Question: Looking at the figure, what chart type is it?
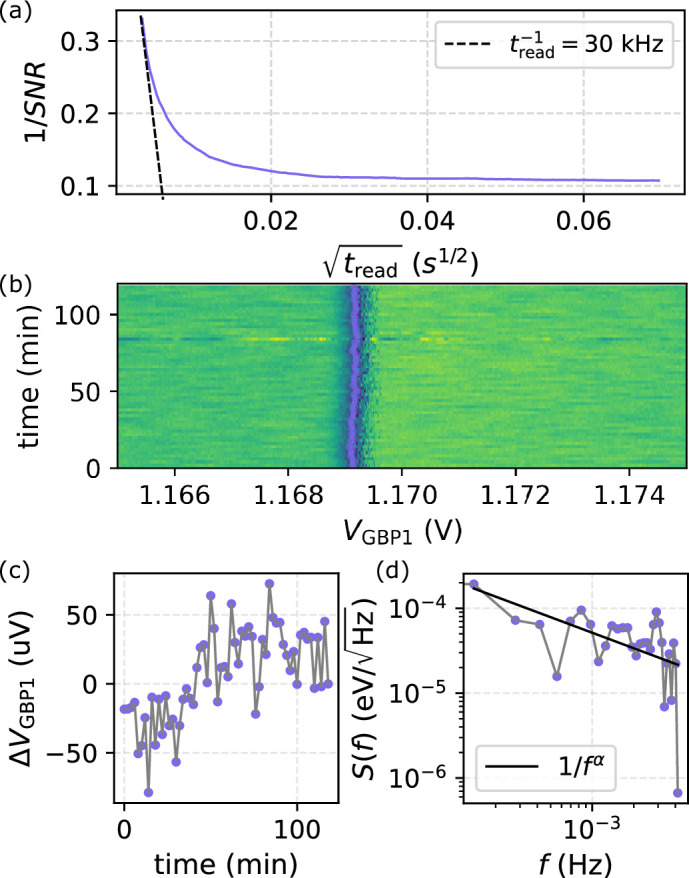
Answer: histogram